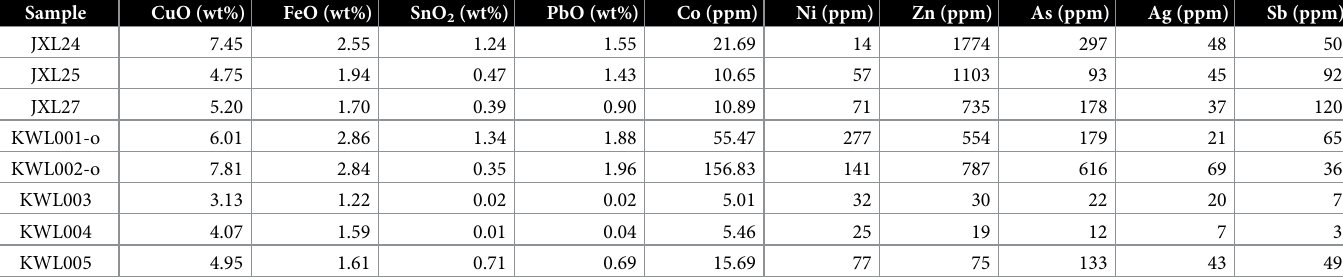
Table 2. Chemical composition in relation to the use of copper colorant. Sample